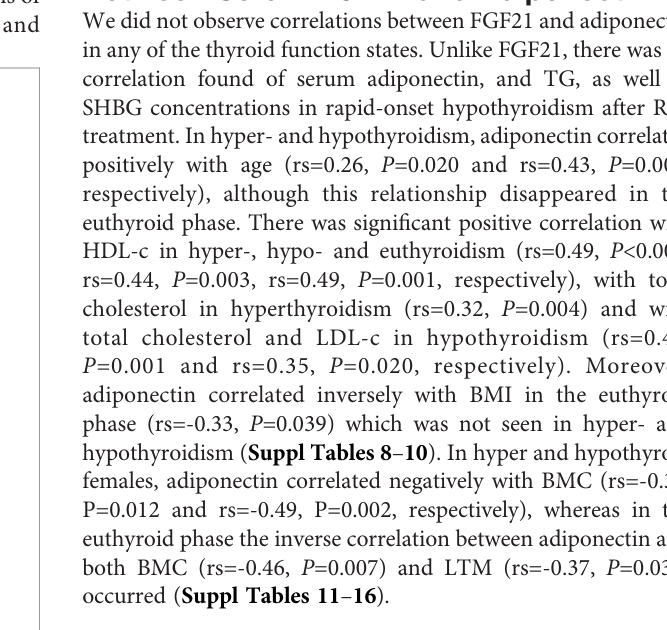
BA FIGURE 2 | FGF21 (A) and adiponectin (B) serum levels in hyperthyroid and hypothyroid patients in comparison to controls. FGF21, fi broblast growth factor 21. Data presented as median (interquartile range). N.S. represents non-statistically signi fi cant difference. P<0.05 was considered signi fi